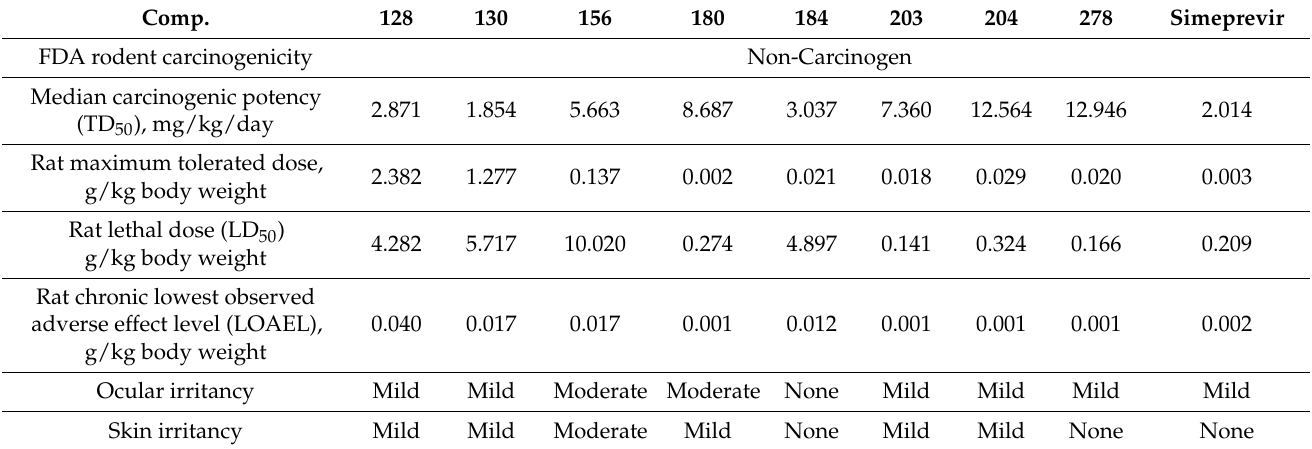
Table 5. Toxicity models of the antiviral compounds and the reference drug.